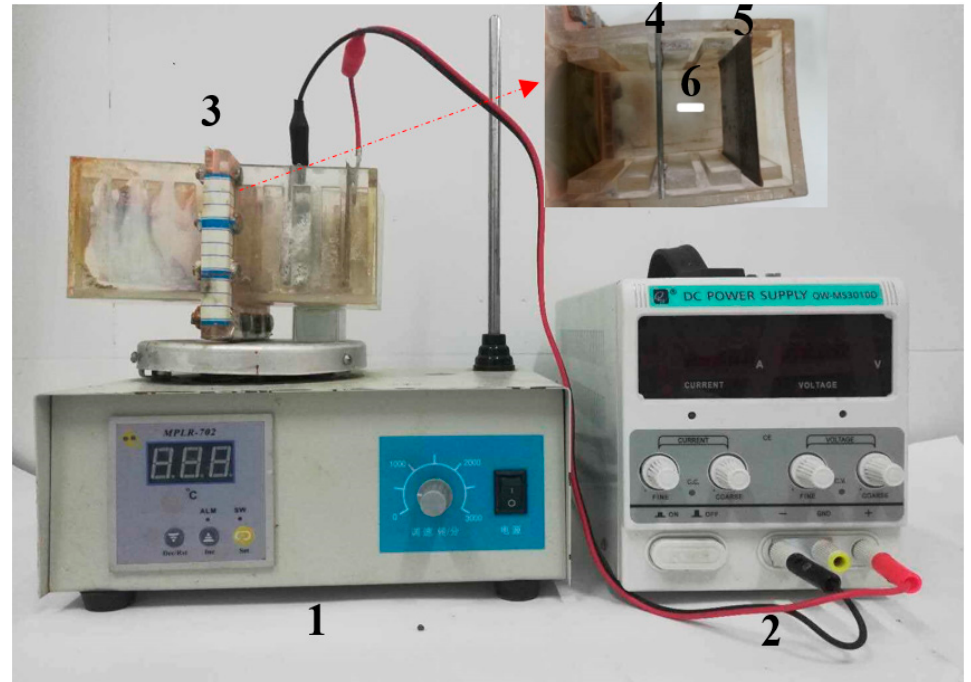
Figure 1. Electrocoagulation (EC) experimental set-up: (1) Magnetic stirrer; (2) DC power supply; (3) electrolytic cell; (4) anode plate; (5) cathode plate; (6) magnetic bar-stirrer.